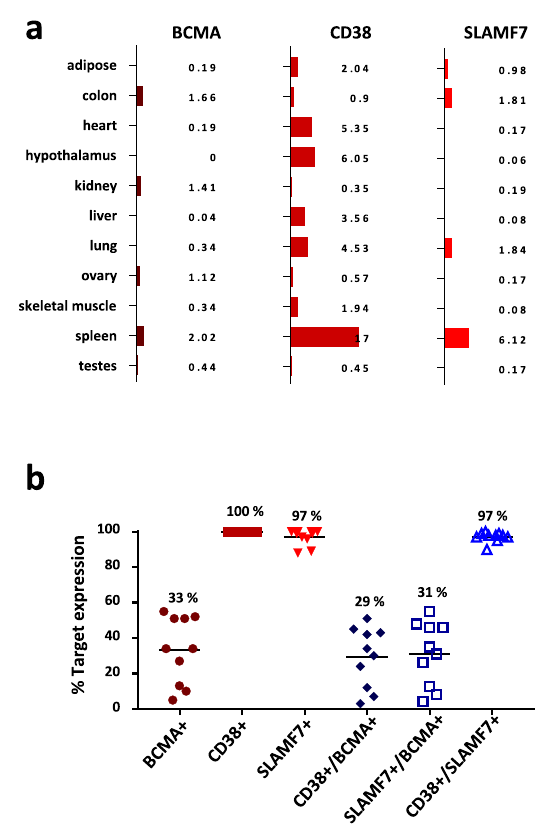
Fig. 1 Combinatorial expression of BCMA, CD38, and SLAMF7 antigens on multiple myeloma and healthy tissues. a mRNA expression patterns of BCMA, CD38, and SLAMF7 on healthy tissues by publicly available Cell fi nder software. b Co-expression of BCMA, CD38, and SLAMF7 on primary MM cells. The protein expression level of selected targets was evaluated on ten primary myeloma cell populations by fl ow cytometry techniques ( n = 10, pooled data are